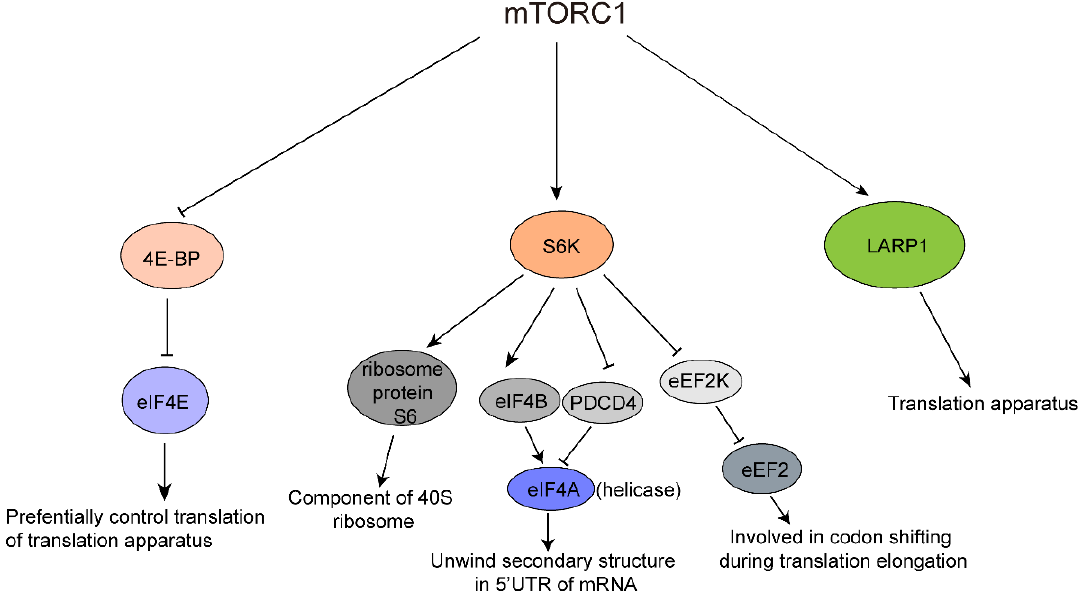
Figure 2. The main downstream signaling pathways of mTORC1. Arrows indicate facilitation and activation, and blocks indicate inhibition.